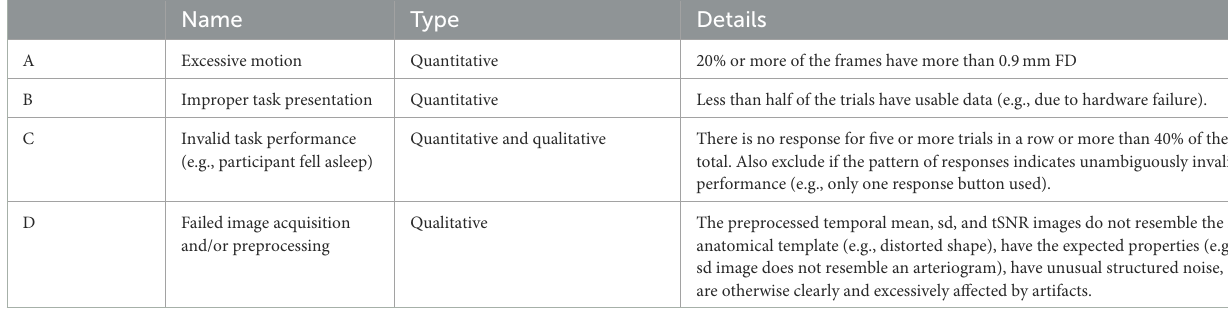
TABLE 1 Task-based fMRI QC criteria: exclude the run for a subject